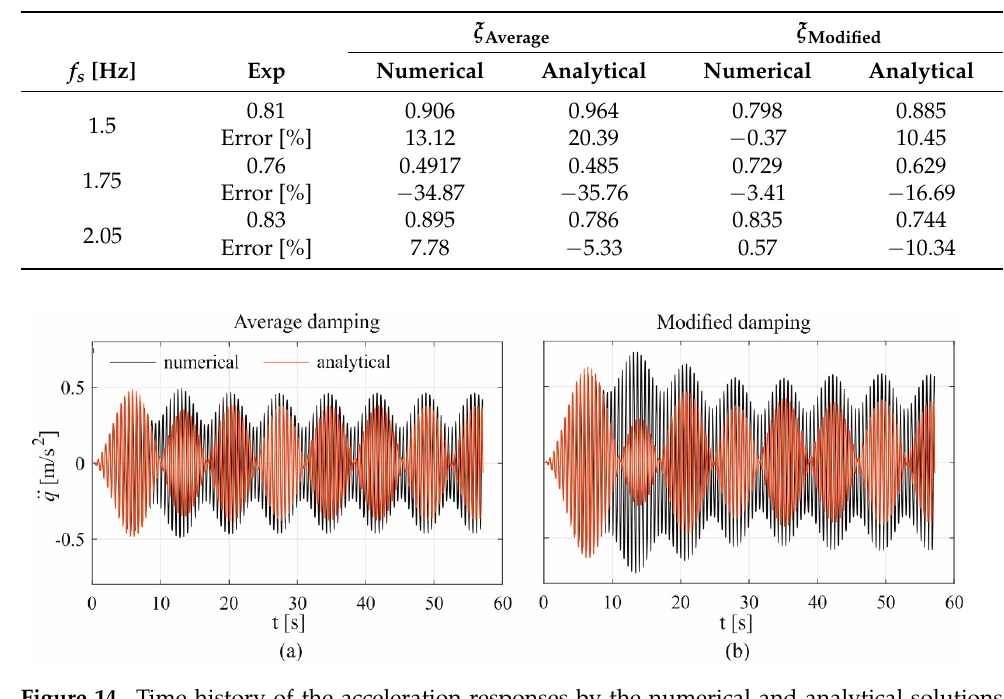
Figure 14. Time history of the acceleration responses by the numerical and analytical solutions predicted with average ( a ) and modified damping ( b ) during a single pedestrian crossing with a step frequency of 1.75 Hz.